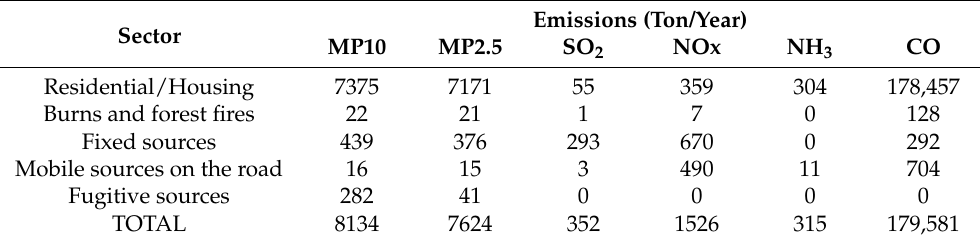
Table 1. Emissions inventory according to the General Analysis of the Economic and Social Impact (GAESI), based on the year 2013 [27] (ADP,